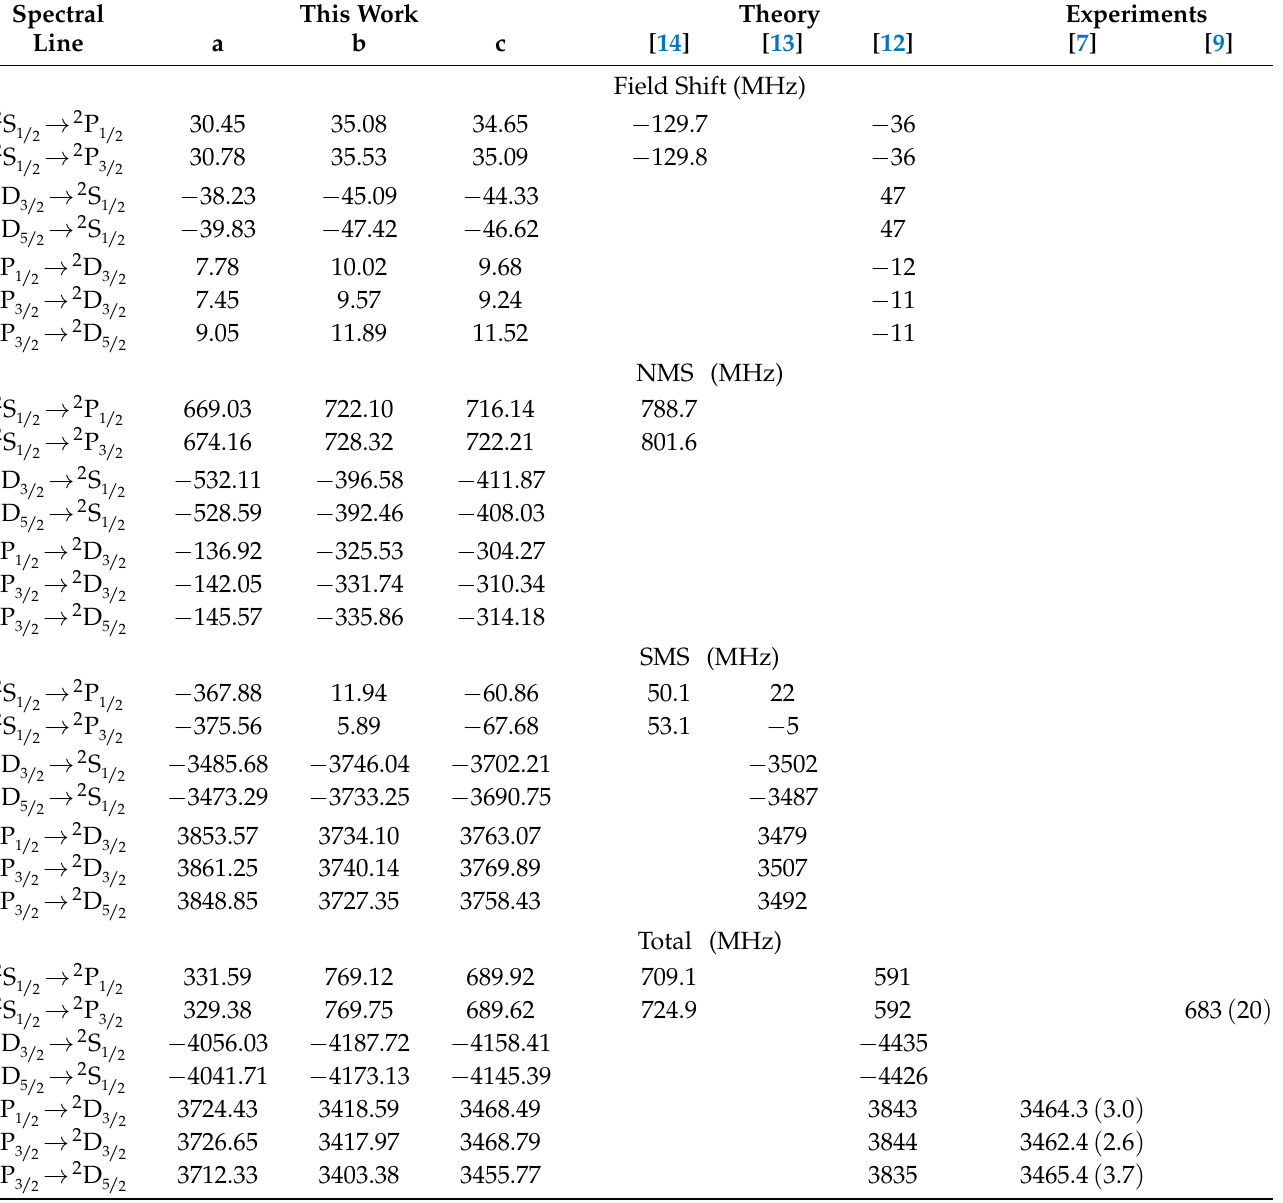
Table 3. Comparison of isotope shifts for various spectral lines between different numerical and experimental data for the isotope pair 40 Ca II and 43 Ca II, δν 40 − 43 , in MHz. For this work, the three columns refer to data calculated using: a. * DHF, b. RCCSD, and c. RCC SD(T), as explaind in the text.